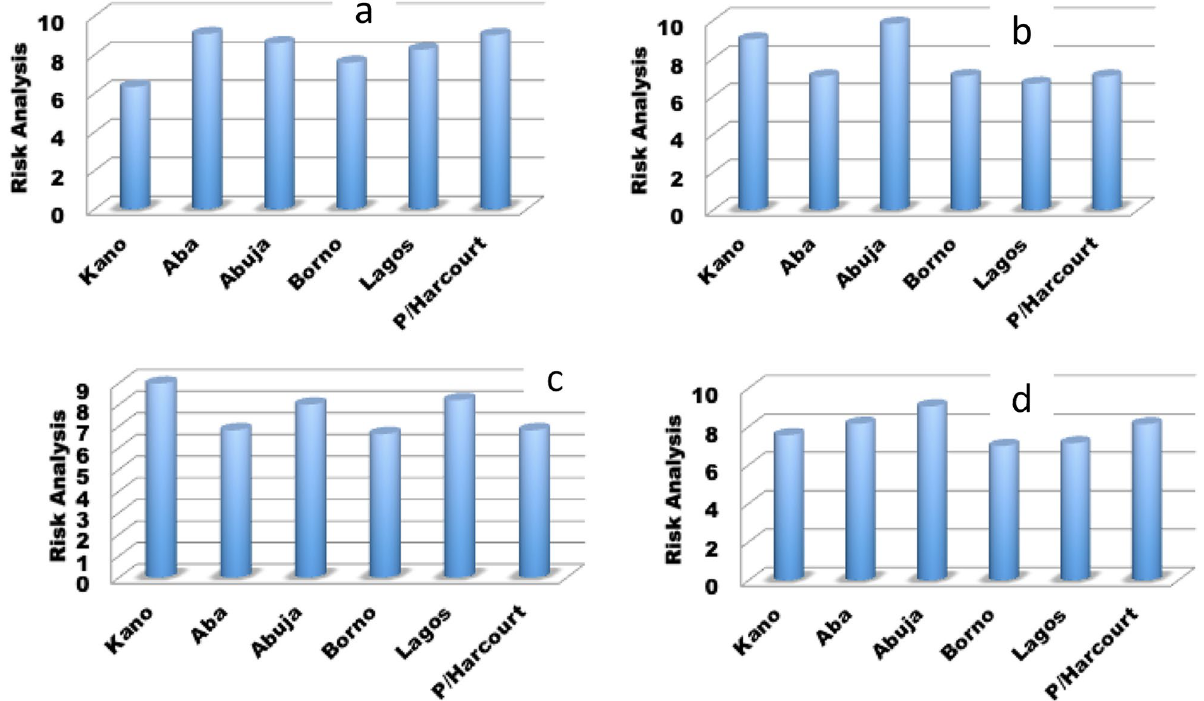
Figure 10. Risk analysis ( a ) early dry season-SON ( b ) late dry season-DJF ( c ) early wet season-MAM ( d ) late dry